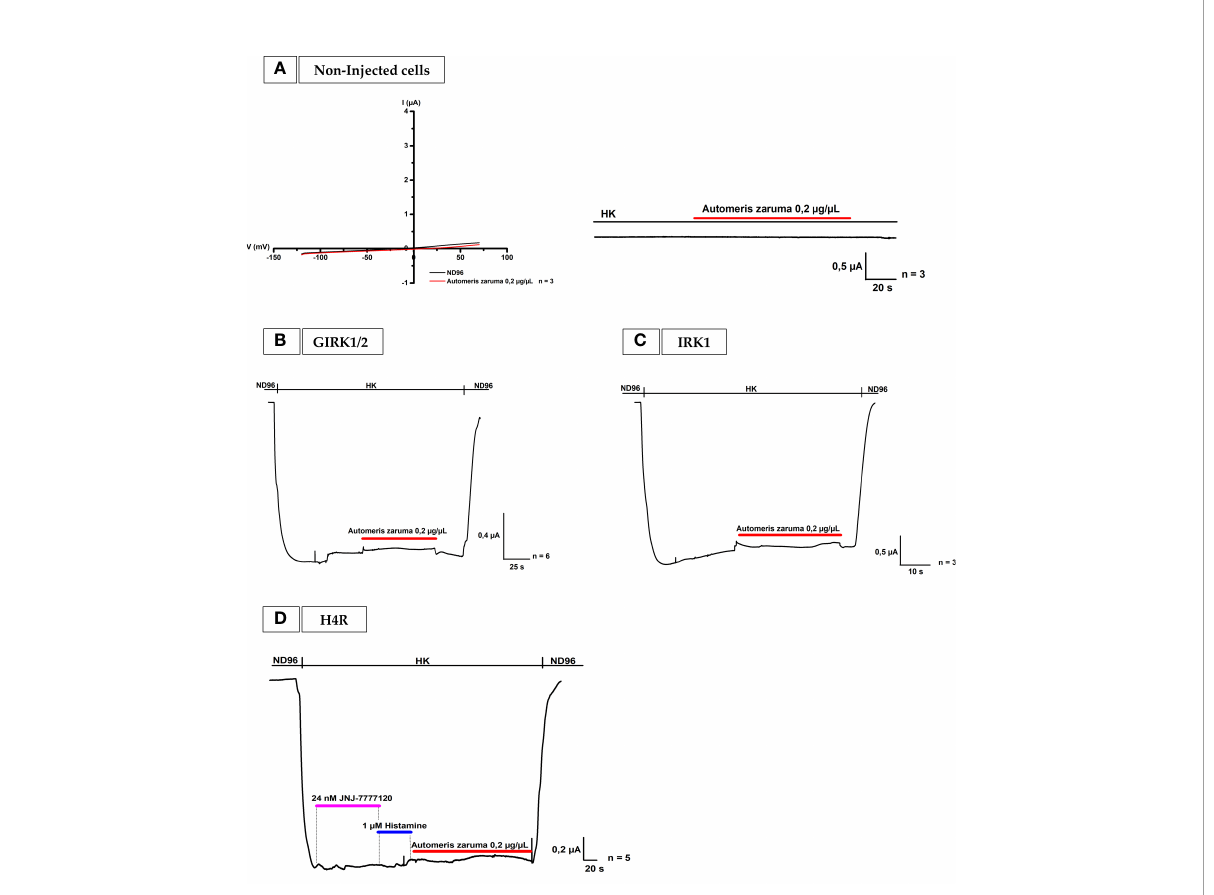
FIGURE 3 Effect by A. zaruma venom extract on non-injected cells, GIRK1 and GIRK2, IRK1 injected cells and in the presence of a selective H4R antagonist. (A) Two validation curves represent no appreciable current enhancement by A. zaruma venom extract (red) in non-injected Xenopus laevis oocytes. (B) A validation current trace show that no signi fi cant current was induced by A. zaruma extract (red) in Xenopus laevis oocytes injected with GIRK1 and GIRK2. (C) A validation curve visualizes no current increase by A. zaruma venom extract on oocytes injected with IRK1. (D) The current enhancement by histamine (blue) and 0.2 µg/µL A. zaruma venom extract (red) disappeared in the presence of JNJ 7777120 antagonist (pink). All experiments were repeated at least three times (n ≥ 3).